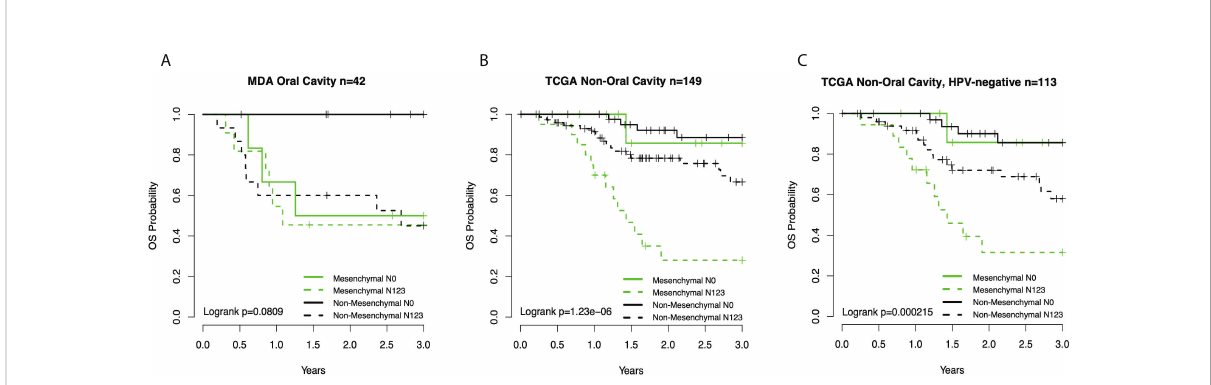
FIGURE 3 (A) Kaplan – Meier overall survival (OS) curves for oral cavity cancer patients (13) by subtype-node status group. (B) Curves for TCGA non-OC patients by subtype-node status. (C) Curves TCGA non-OC HPV-negative patients by subtype-node status group. TCGA, The Cancer Genome Atlas; OC, oral cavity; HPV, human